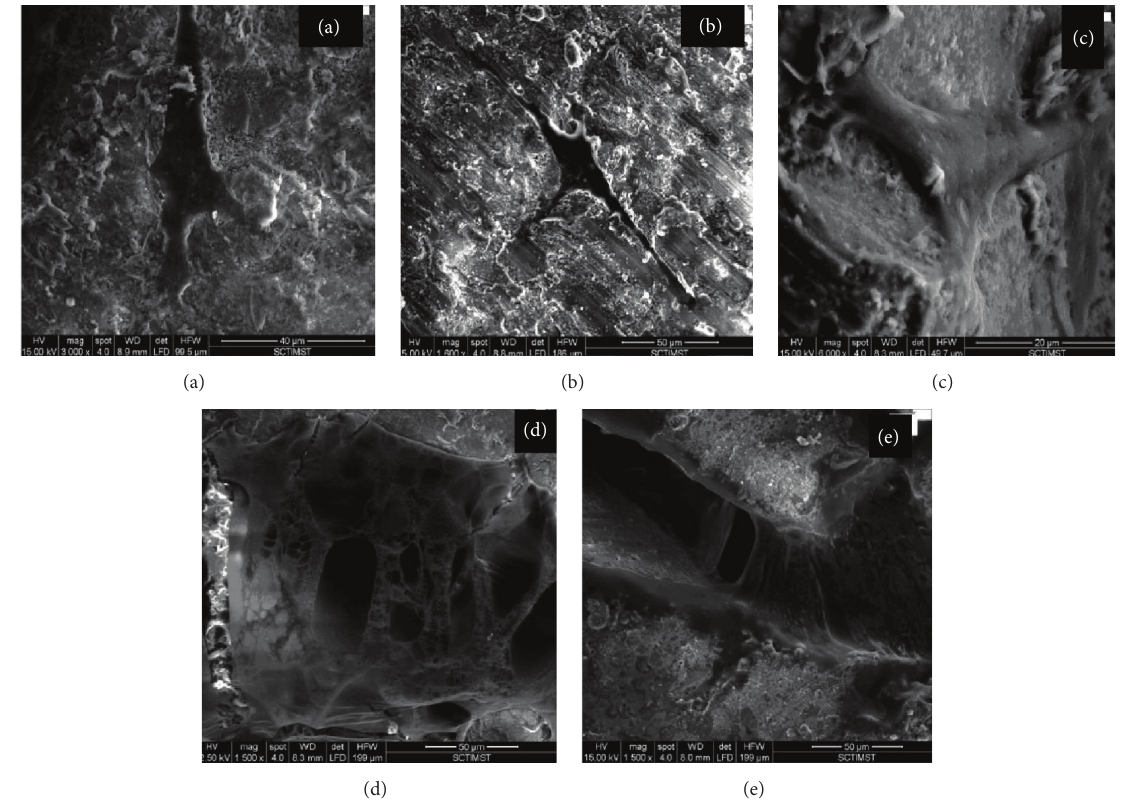
Figure 4: Scanning electron micrographs showing attachment and adhesion of ADMSCs on the device. (a and b) Day 3 attachment of ADMSCs on the device. (c) Day 7 attachment of ADMSCs on the devices showing filopodia formation. (d and e) Day 14 attachment of ADMSCs on the device showing layers of cells (ADMSCs) on the device.